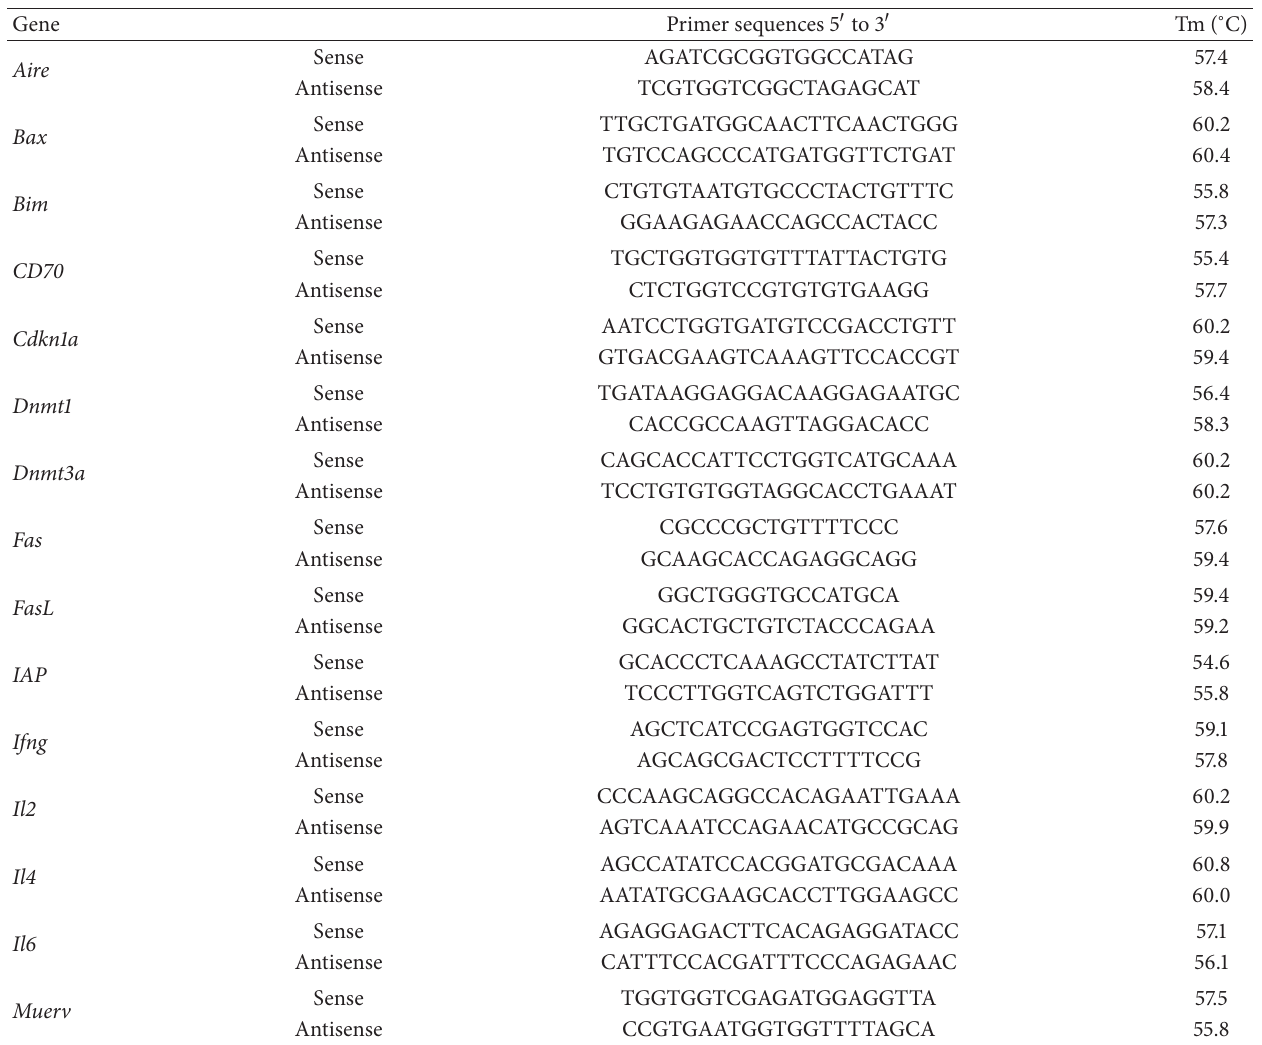
Table 1: Primer sequences used for